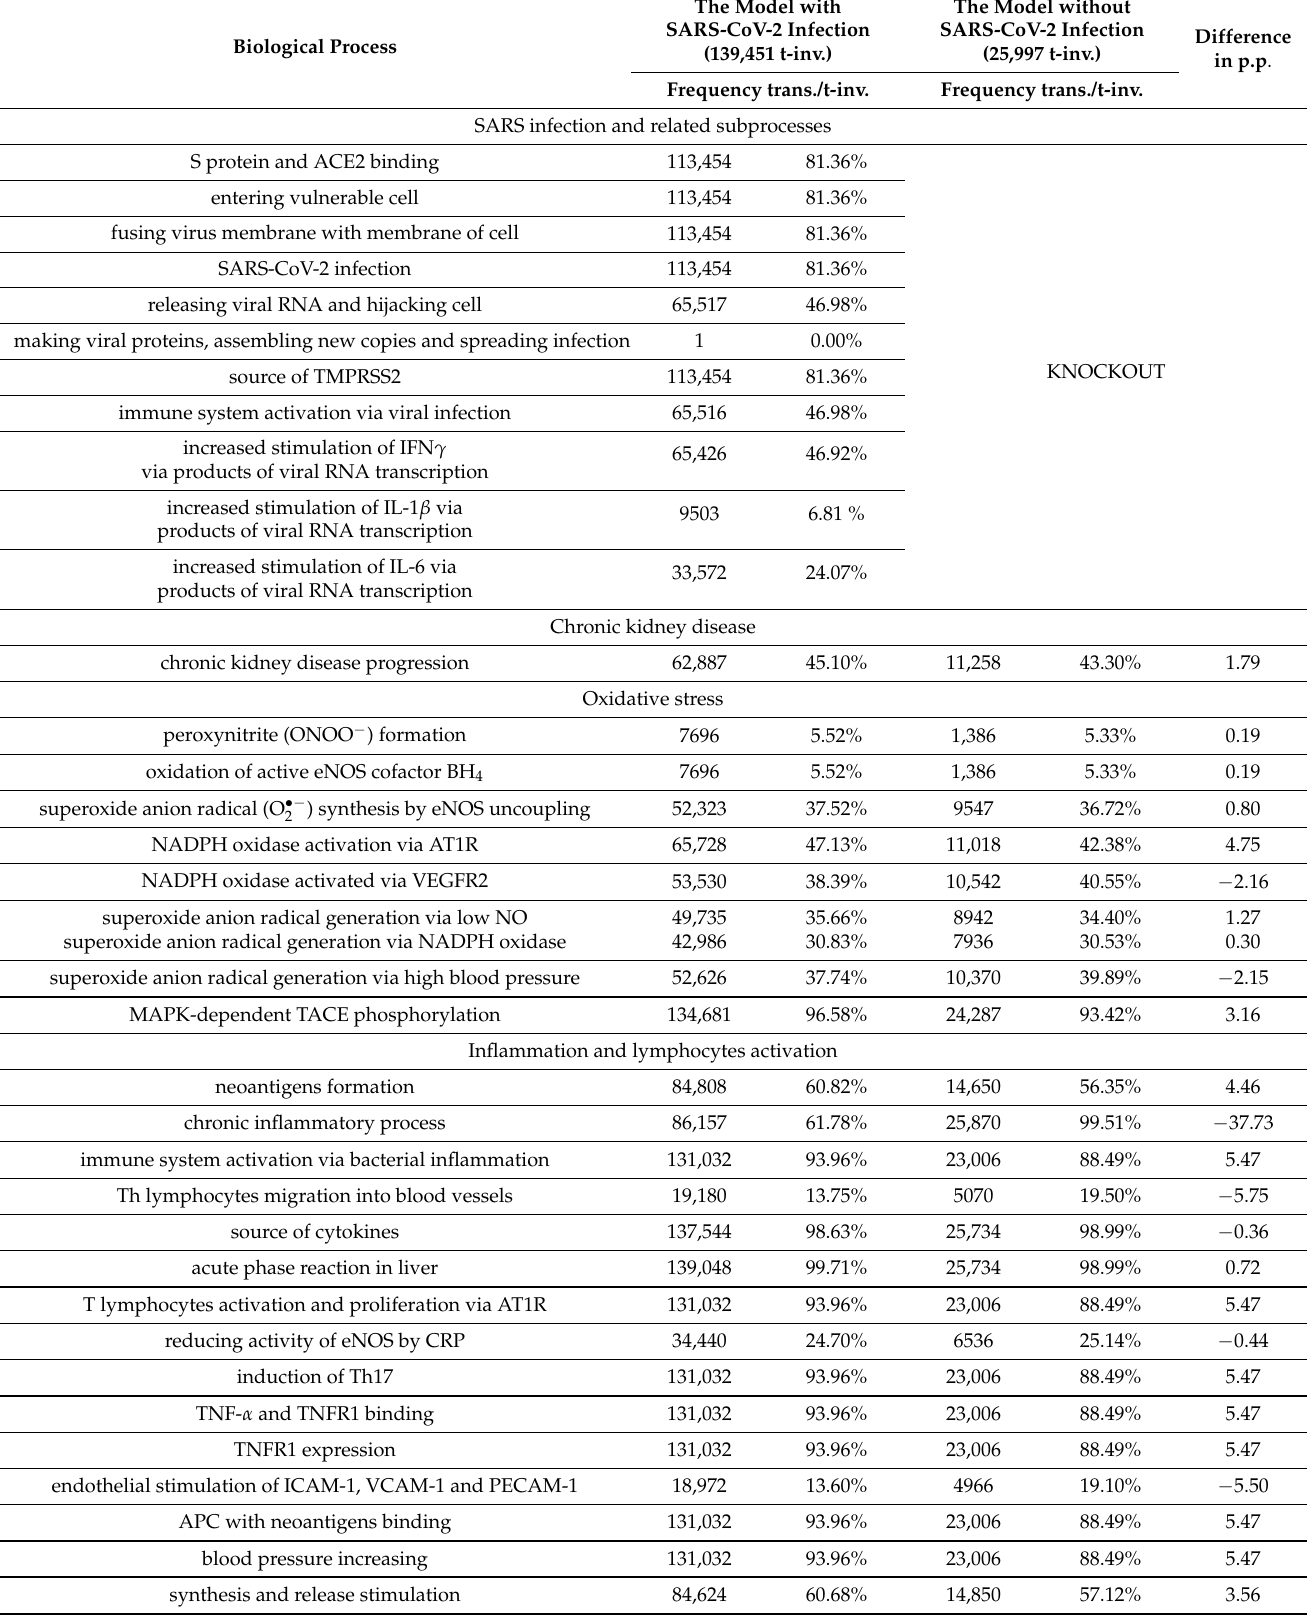
Table 4. Comparison of the significance analysis between the model with SARS-CoV-2 and without the virus (139,451 t-inv. vs. 25,997 t-inv.) *.